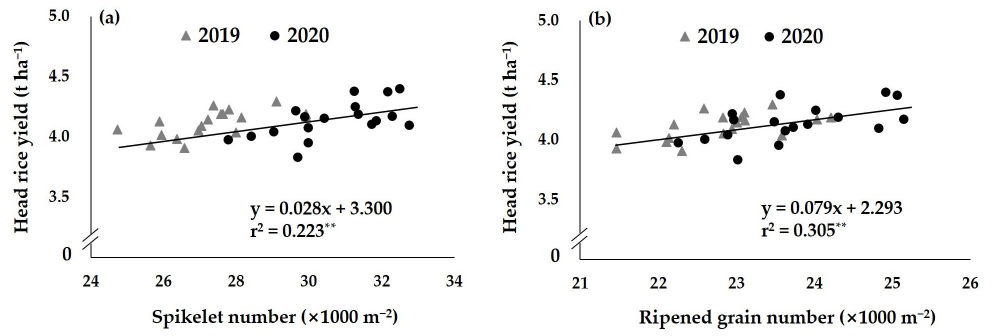
Figure 5. Relationship between the head rice yield and ( a ) spikelet number m − 2 and ( b ) ripened grain number m − 2 . **: significant at p < 0.01.